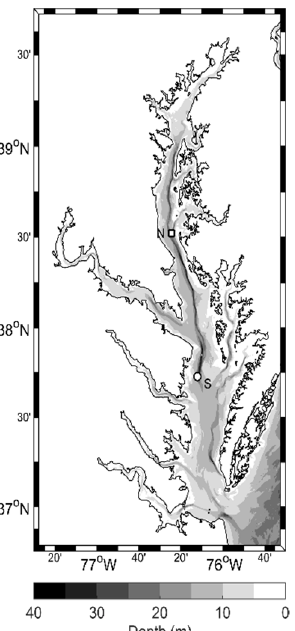
Figure 1. The study area of the Dead Zone Zooplankton research project. The square indicates the North Station (38.528 ◦ N, 76.418 ◦ W) and the circle indicates the South Station (37.738 ◦ N, 76.208 ◦ W), and the grey contouring indicates the water depth of Chesapeake Bay.